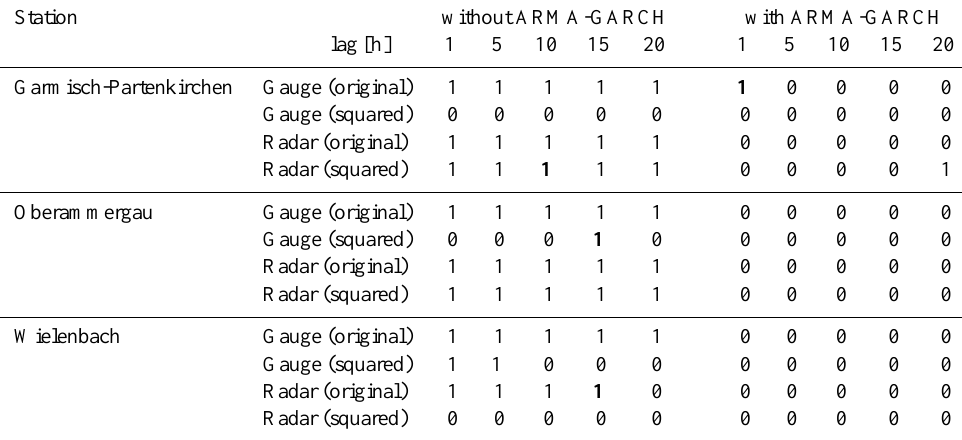
Table 4. Ljung-Box Q-test results for three observation stations and their corresponding radar grid cells. The test indicates whether or not the time series exhibit autocorrelation for a given number of lags [hours]. One tests the null hypothesis that a series exhibits no autocorrelation for a fixed number of lags against the alternative hypothesis that the autocorrelation is nonzero. “1” indicates that the null hypothesis is rejected (i.e. autocorrelation (original) and heteroskedasticity (squared)), and “0” indicates no autocorrelation/heteroskedasticity for any given time lag and level of significance (significant at α =0.05 (bold), or α =0.01 level of significance (normal)).